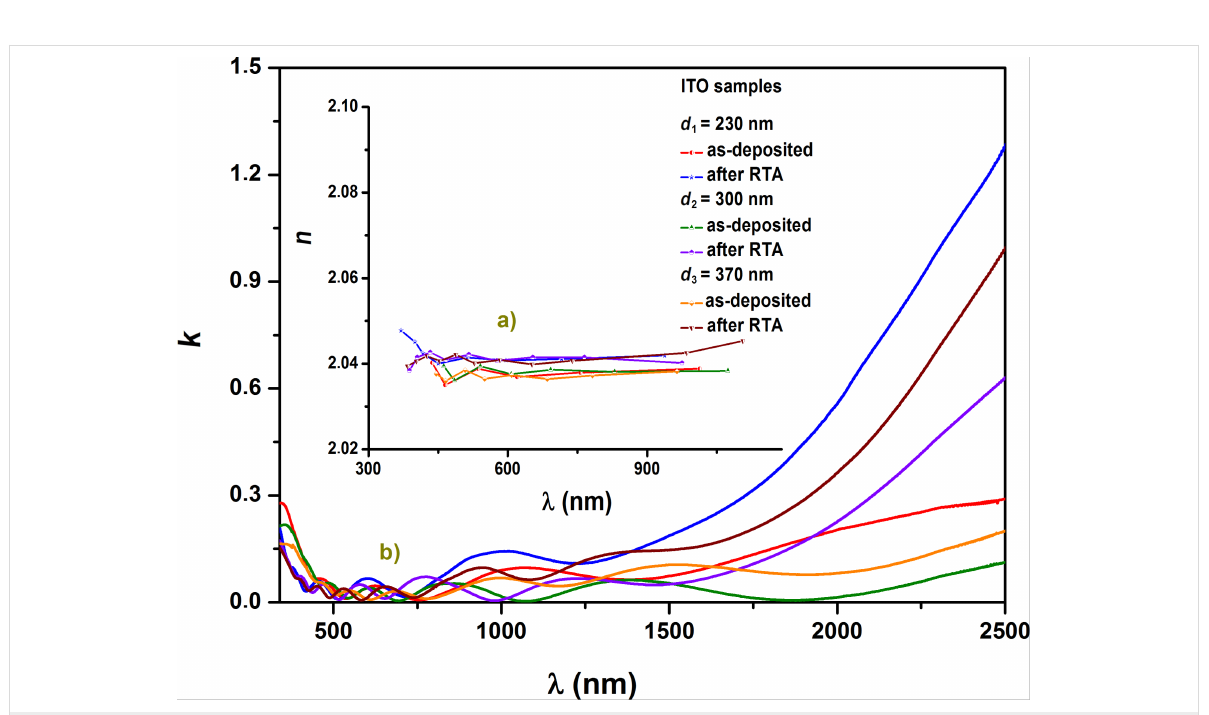
Figure 6: a) Refractive index dependence on the wavelength (dispersion) and b) extinction coefficient dependence on the wavelength for the as-deposited and RTA-treated ITO